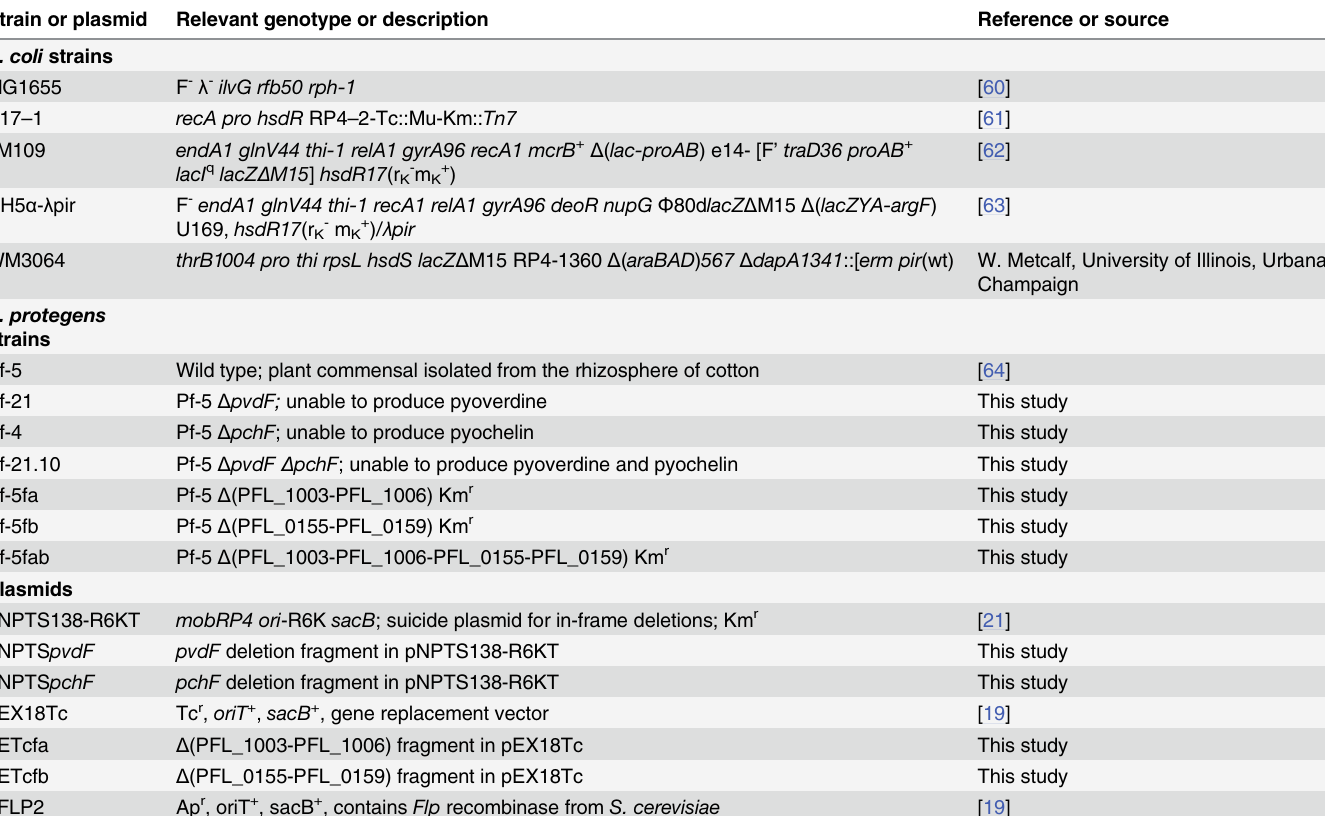
Table 1. Bacterial strains and plasmids used in this study. Strain or